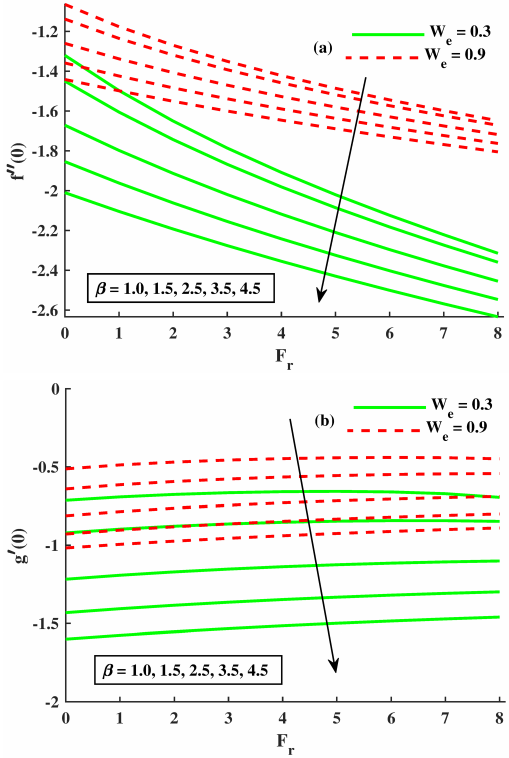
Figure 8. The effects of β , F r , & W e on Skin